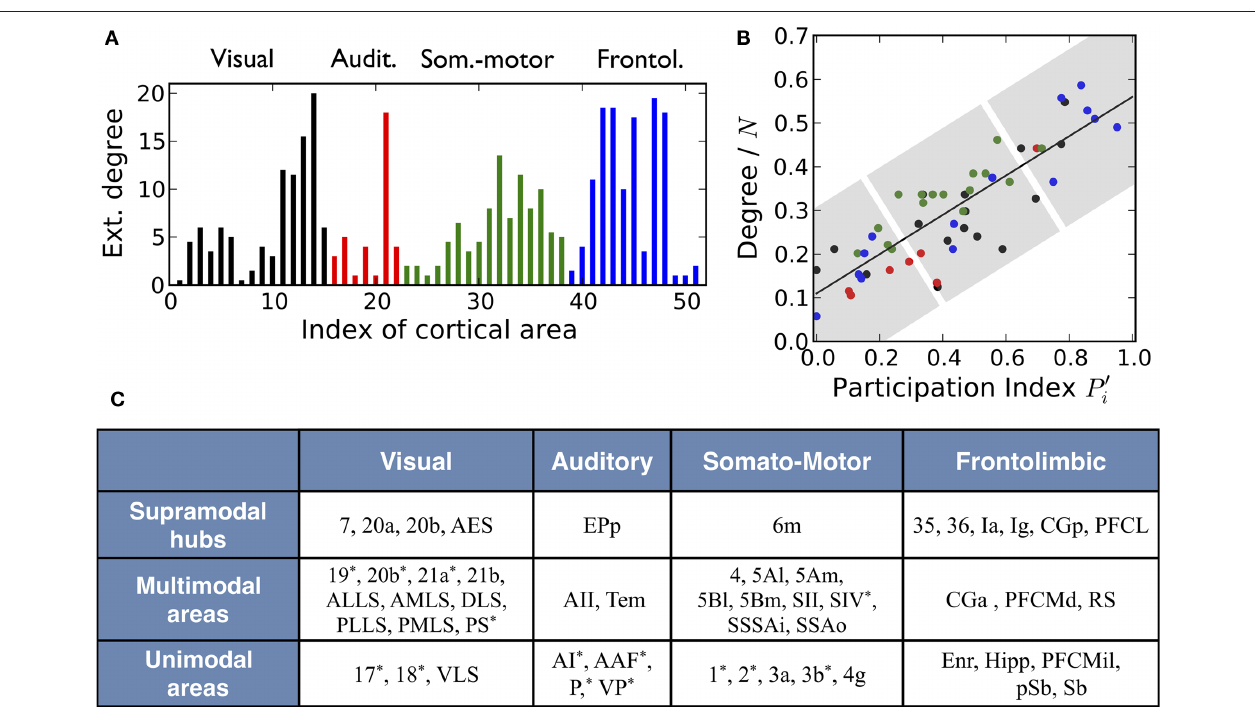
network. This trend permits a classification of cortical areas into three categories (highlighted be shaded regions): unimodal areas, multimodal areas, and supramodal hubs (C) . Areas marked with an asterisk ( * ) contain either retinotopic, tonotopic, or somatotopic maps of the sensory